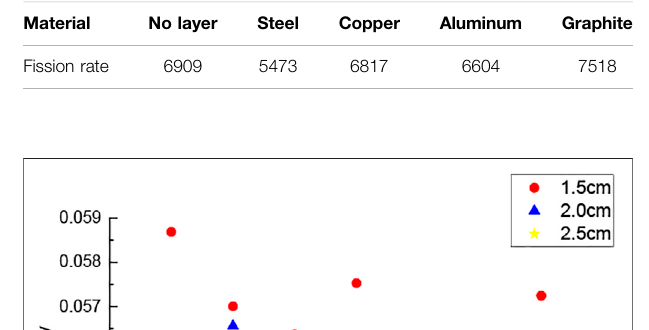
TABLE 10 | Fission rate under different packaging materials.